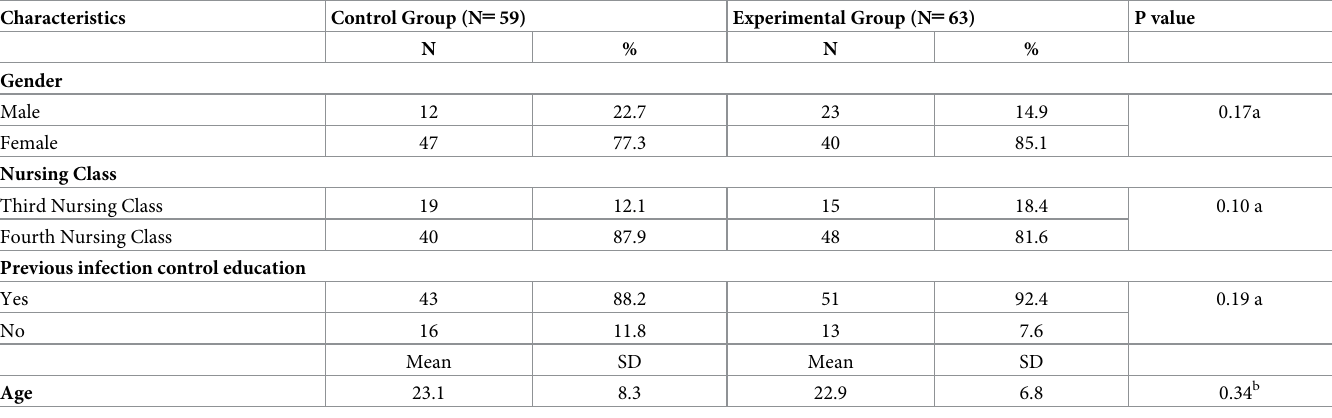
Table 1. Descriptive characteristics of the control group and the experimental group.